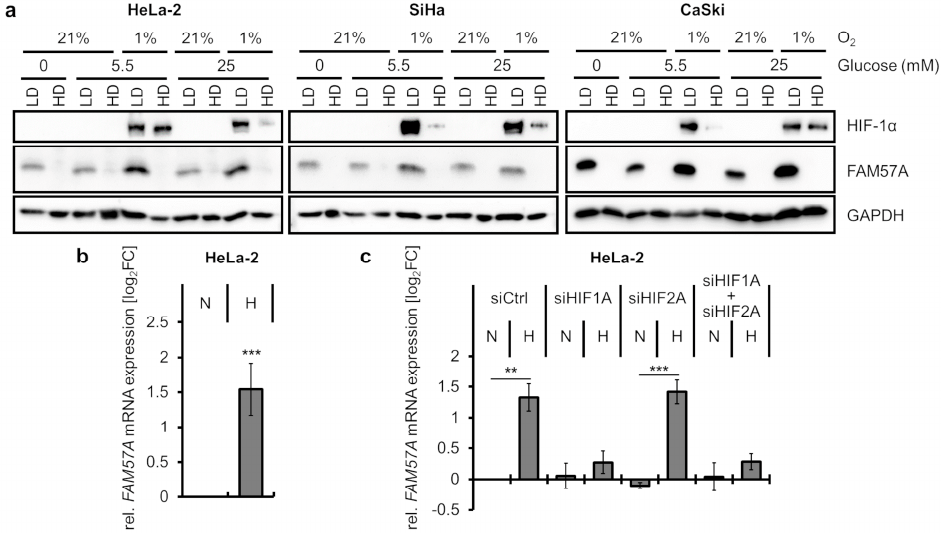
Figure 3. FAM57A expression in relation to cell density, normoxia/hypoxia, and glucose supply. ( a ) Immunoblot analyses of HPV-positive cancer cells seeded at LD or HD. After 24 h, cells were cultivated at normoxic (21% O 2 ) or hypoxic (1% O 2 ) conditions and under different glucose concentrations, as indicated, for another 24 h before harvesting. HIF-1 α , hypoxia marker; GAPDH, loading control. ( b ) qRT-PCR analyses determining the mean (log 2 FC) FAM57A transcript levels in HeLa-2 cells cultivated at hypoxia (H; 1% O 2 ) compared to normoxia (N; 21% O 2 ) (log 2 FC = 0) with standard deviations from 4 independent experiments. Statistically significant differences are determined by one-way ANOVA. ***: p < 0.001. ( c ) qRT-PCR analyses measuring FAM57A transcript levels following silencing HIF1A (siHIF1A) or HIF2A (siHIF2A) expression, either alone or in combination. Displayed are the log 2 FC of mean FAM57A transcript levels in normoxic (N) and hypoxic (H) cells, relative to control siRNA (siCtrl)-transfected cells cultivated at normoxia (log 2 FC = 0) from 3 independent experiments with standard deviations. Statistically significant differences are determined by one-way ANOVA. **: p < 0.01, ***: p < 0.001.